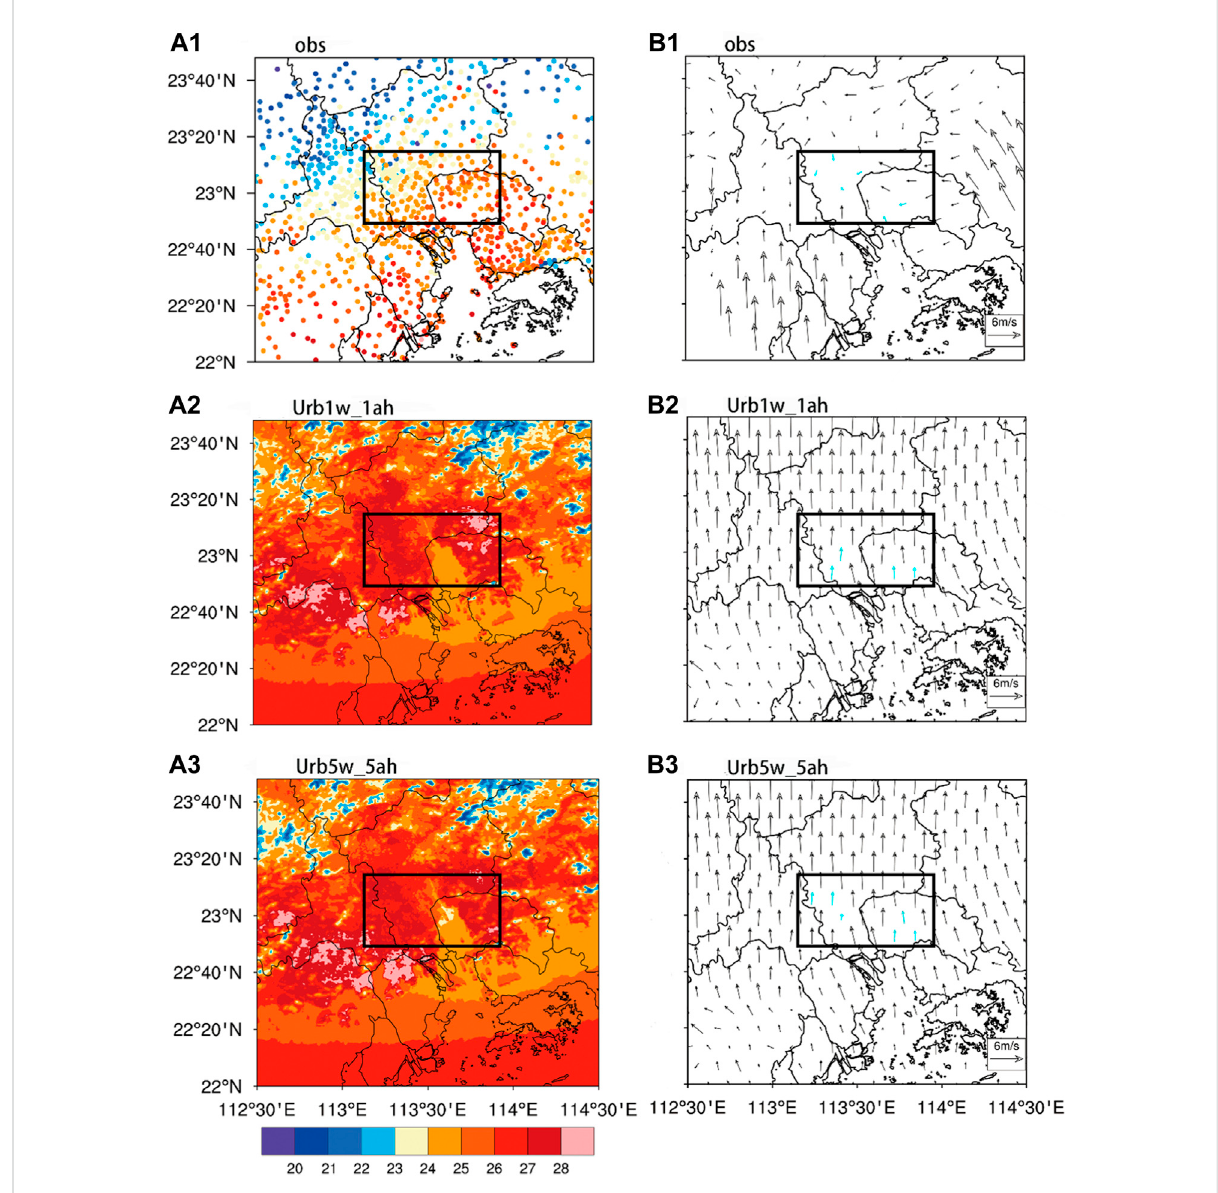
FIGURE 6 Comparison between observations and two sets of model-simulated meteorological elements from 0,800 to 1000 LST 20 April: (A1) observations of 2 m temperature (unit: ° C); (A2) Urb1w_1ah simulated 2 m temperature (unit: ° C); (A3) Urb5w_5ah simulated 2 m temperature (unit: ° C); (B1) observationsof10 mwindspeed(unit:m · s − 1 ); (B2) Urb1w_1ahsimulated10 mwindspeed(unit:m · s − 1 ); (B3) Urb5w_5ahsimulated10 mwind speed (unit: m · s − 1 ). (The black box represents the precipitation centers in urban areas, the cyan arrows represent the locations where the horizontal wind speed decreases in urban